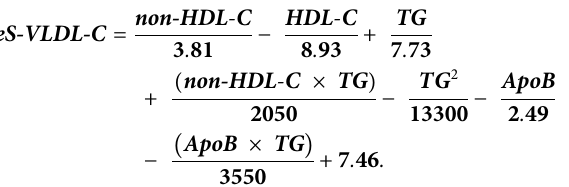
Frontiers in Genetics |